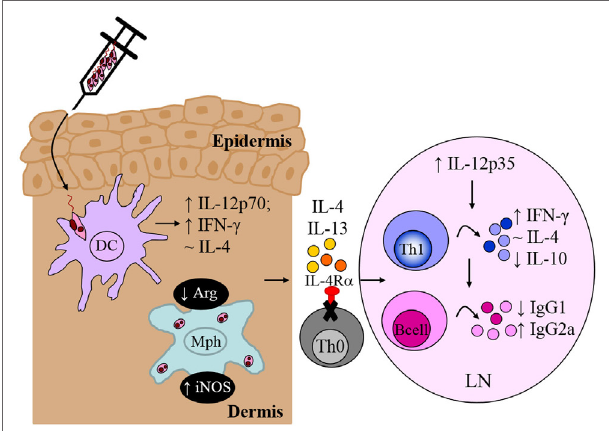
FiGURe 8 | CD4 + T cell-specific interleukin-4 receptor alpha (IL-4R α )- deficient mice develop a polarized Th1/type I immune response. In the absence of interleukin-4 (IL-4)-responsive T cells, normally susceptible BALB/c mice developed a healing phenotype upon experimental infection in the footpad, characterized by increased IFN- γ and IgG2a and concomitantly reduced IL-10 and IgG1 compared to littermate BALB/c mice. Interestingly, CD4 + T cell-specific IL-4R α -deficient mice maintained equivalent IL-4 production to control littermate BALB/c mice. Illustration prepared from Radwanska et al. (10). DC, dendritic cells; Mph, macrophage; LN, lymph node; Th0, naive T cell; Th1, T helper